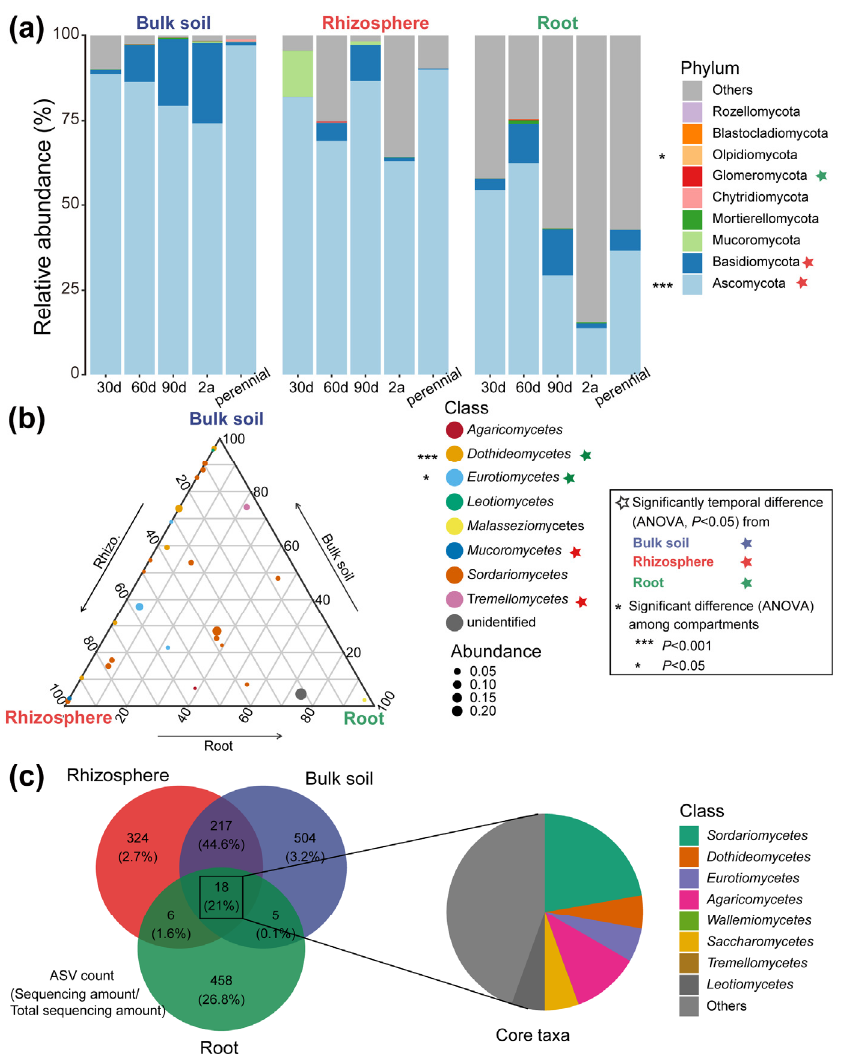
Figure 1. Abundance of A. sparsifolia root-associated fungal taxa. ( a ) Average relative abundances at the phylum level. ( b ) Ternary plot indicating the fraction of top 30 genera fractions in each compartment. Circles represent the classes in which these genera belong, and circle size represents the average abundance. ( c ) The Venn diagram shows the number of specific and common ASVs and the proportion of the corresponding sequence to the total sequence. The pie chart shows the composition of these core taxa at the class level. Abbreviations: 30 d, 30 days old; 60 d, 60 days old; 90 d, 90 days old; 2 a, 2 years old; perennial, over 3 years old.